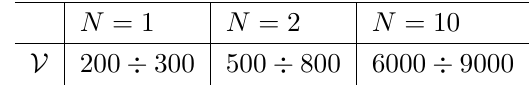
Table 3 . Predicted overall volumes for different values of N imposing 100% of